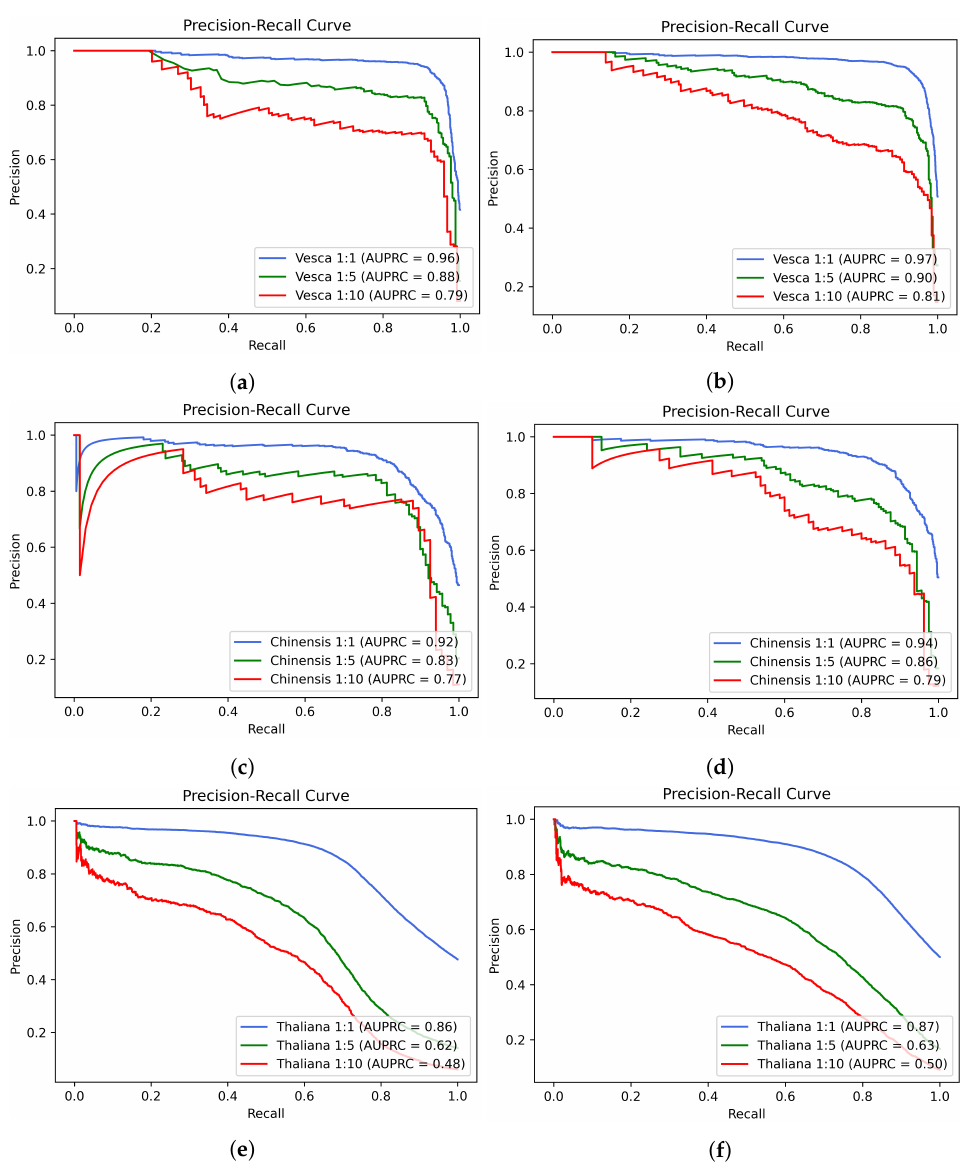
Figure 1. Comparison of the AUPRCs generated with and without ElasticNet on imbalanced datasets of F. vesca , R. chinensis , and A. thaliana . ( a ) F. vesca (without ElasticNet); ( b ) F. vesca (with